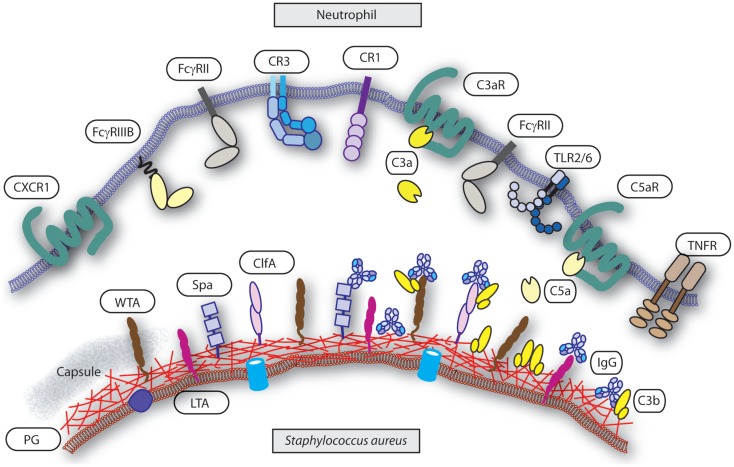
Interface neutrophil and S. aureus. Several groups of receptors mediate neutrophils recognition of S. aureus upon opsonization and others are involved in activation or priming of phagocytosis. Targets on the S. aureus surface are the cell wall components peptidoglycan (PG), wall teichoic acid (WTA), lipoteichoic acid (LTA), capsule (“gray area”), and representative associated proteins clumping factor A (ClfA) and protein-A (Spa). Targets are decorated with serum derived opsonins IgG (binding with their Fab part) and C3b. Note the reverse Fc-dependent association of IgG with Spa. Receptors on the neutrophil surface involved in recognition of the opsonized S. aureus are FcγRII and FcγRIII for IgG, and CR1 and CR3 for C3b (and iC3b). Examples of receptors on the neutrophil involved in priming or activation of phagocytosis are complement receptors C3aR for C3a and C5aR for C5a, CXCR1 for il-8, and TNFR for TNFα. The heterodimer TLR2/TLR6 represents a common pattern recognition receptor for bacterial lipoproteins.